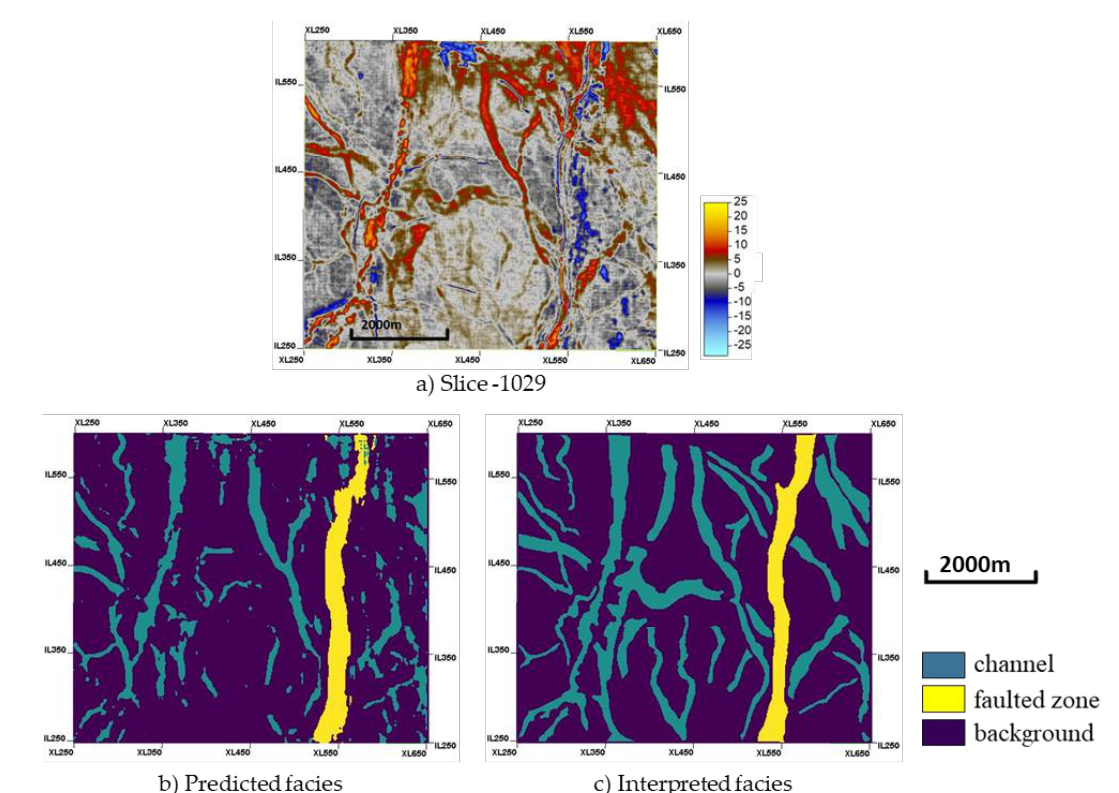
Figure 16. Prediction ( b ) and an interpreted label ( c ) obtained with the slice -1029 ( a ) from the RIPED dataset.